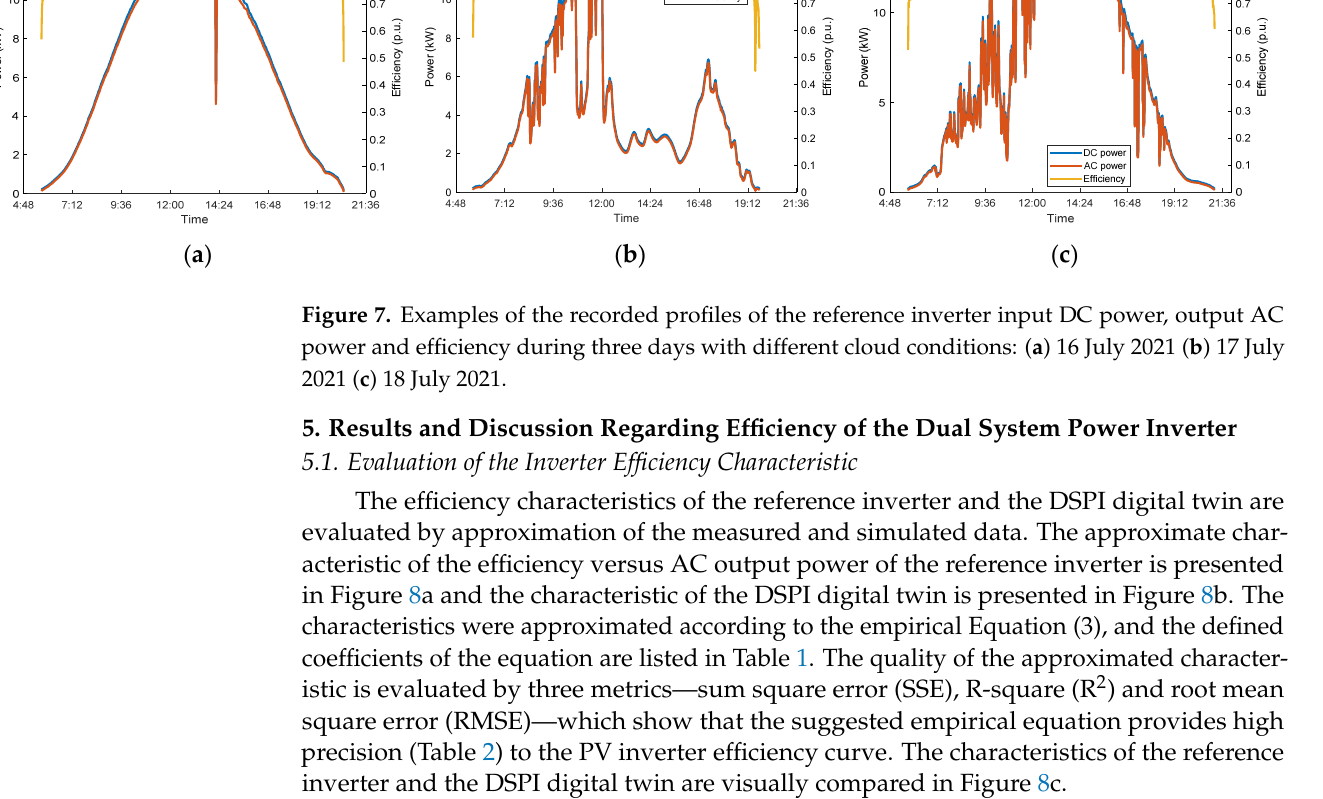
( b ) Figure 6. 3D power profile of the reference solar power plant ( a ) and distribution of annual energy versus AC output power ( b ). To evaluate the efficiency characteristics of the reference inverter, additional meas- urement equipment described in Section 4.1 was used. The electrical parameters of the DC input and AC output of the inverter were recorded from March to July 2021. Although the